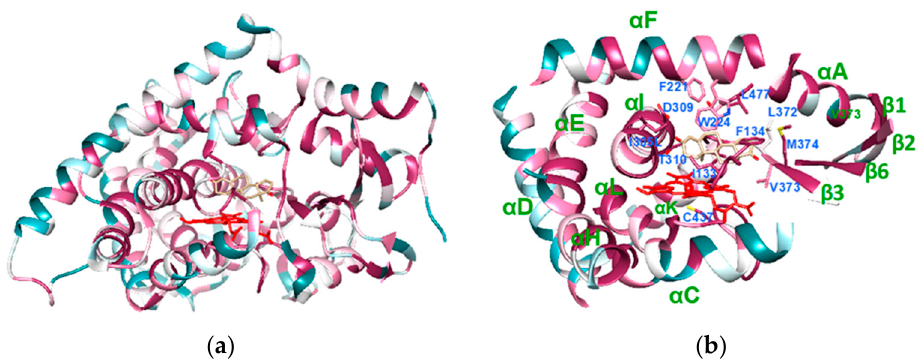
Figure 1. Crystal structure of human aromatase (PDB ID 4KQ8), colored according to the conservation. The violet areas correspond to the more conserved regions, whereas the dark green ones correspond to the most variable. Heme is shown in red and the substrate androstenedione in light brown. ( a ) Overall structure of human aromatase. ( b ) The core structure of aromatase, carrying the most conserved regions. The residues important for substrate binding are also shown.